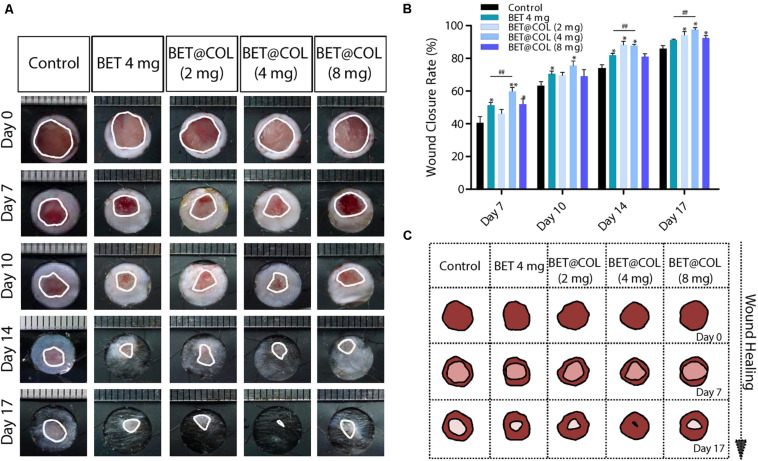
BET@COL significantly resurfaced dermal full-thickness wound. (A) Representative pictures of the macroscopic wound healing processes of the control, free betaine solution treated and BET@COL treated wounds. The rulers in the pictures are shown in millimeters. (B) Statistical wound closure rates of the groups mentioned above, n > 6. (C) Schematic diagram of the traces of in vivo wound closure over 17 days. BET, betaine; COL, collagen. Statistical differences were performed using ANOVA. **p < 0.01, *p < 0.05, compared to control group, ##p < 0.01.